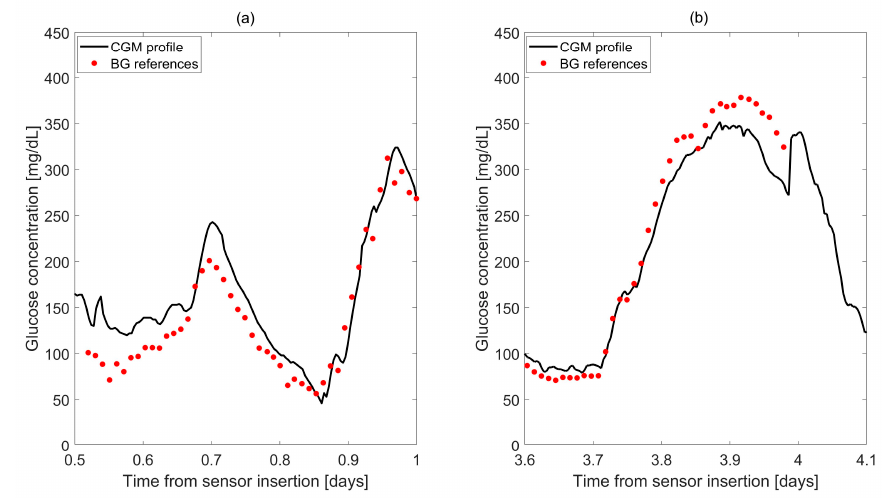
Figure 2. Examples in which the continuous glucose monitoring (CGM) sensor output (continuous line) ( a ) overestimates and ( b ) underestimates the reference blood glucose (BG) (points). Data taken from a previously published study [15].